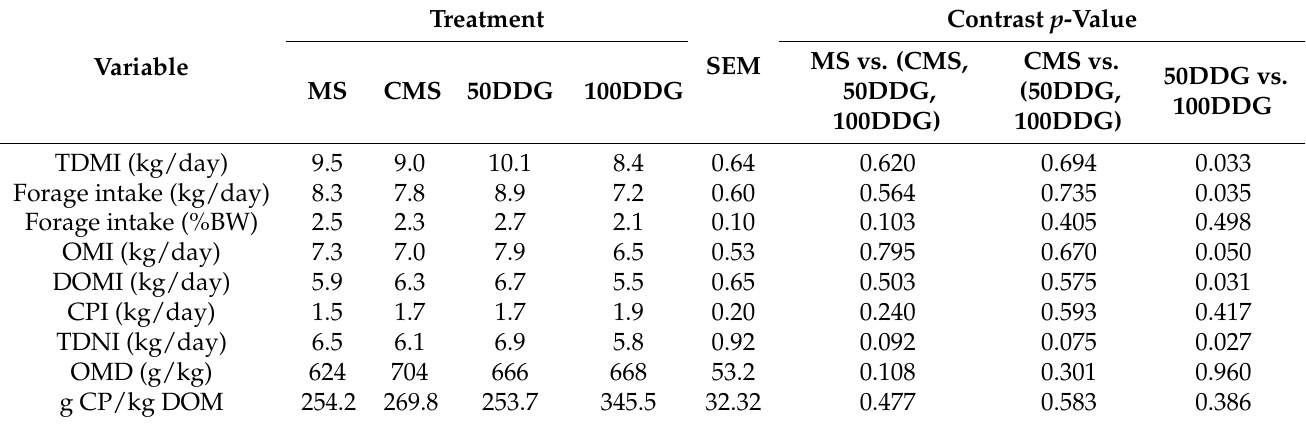
Table 4. Nutrient intake and digestibility in cannulated young bulls fed with four supplementation strategies, grazing Marandu grass during the wet season.